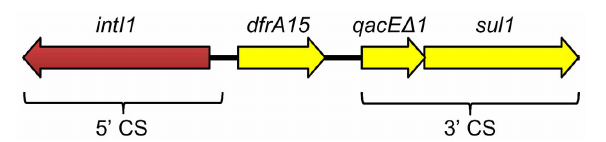
FIGURE 2 | Schematic representation of the class 1 integron located near to the sul2 gene of pVCR94. The dfrA15 cassette confers resistance to trimethoprim. The location of the 5 (cid:4) - and 3 (cid:4) conserved sequences (CS) typical of class 1 integrons are indicated at the bottom.